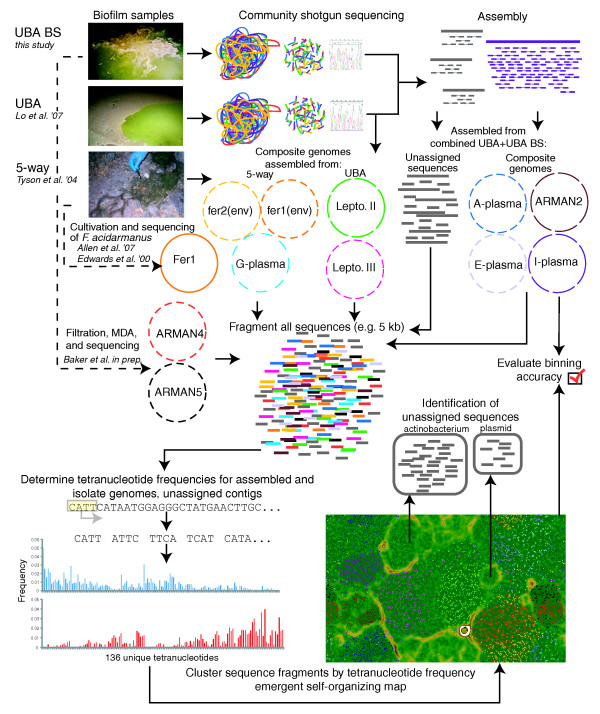
Overview of samples, data, and methods. MDA, Multiple Displacement Amplification. Lo et al. 2007 [55]; Tyson et al. 2004 [16]; Allen et al. 2007 [8]; Edwards et al. 2000 [57].